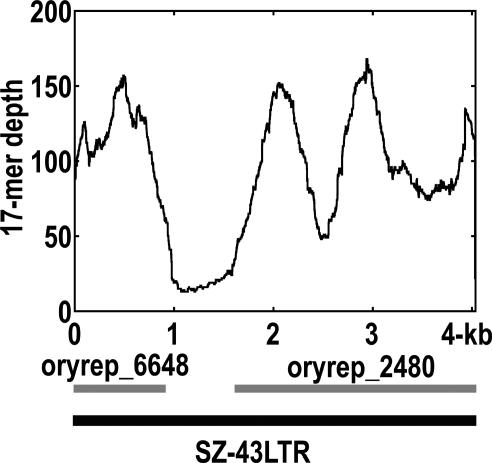
Fragmentation due to Low K-mer DepthSZ-43LTR is the LTR region from a TE that is found as one piece in Repbase, but is recovered by ReAS as two nonoverlapping pieces, with 98% and 97% nucleotide identity to the Repbase entry.